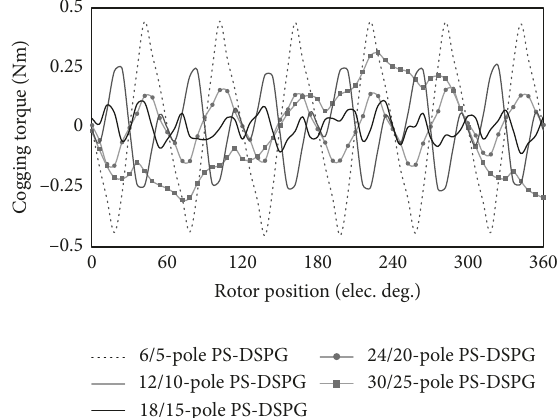
Figure 5: Cogging torque of the proposed PS-DSPG structures at various rotor